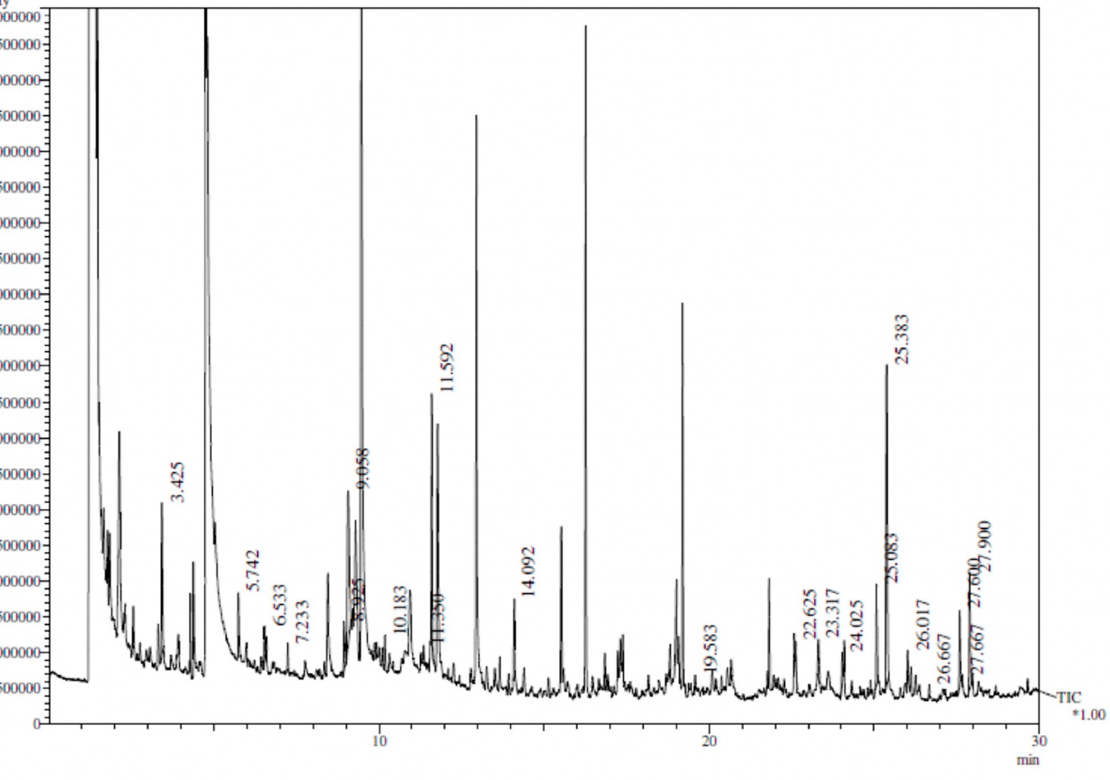
Figure 6. Pyrogram obtained by the Py-GC-MS process of FA extracted from the soil.